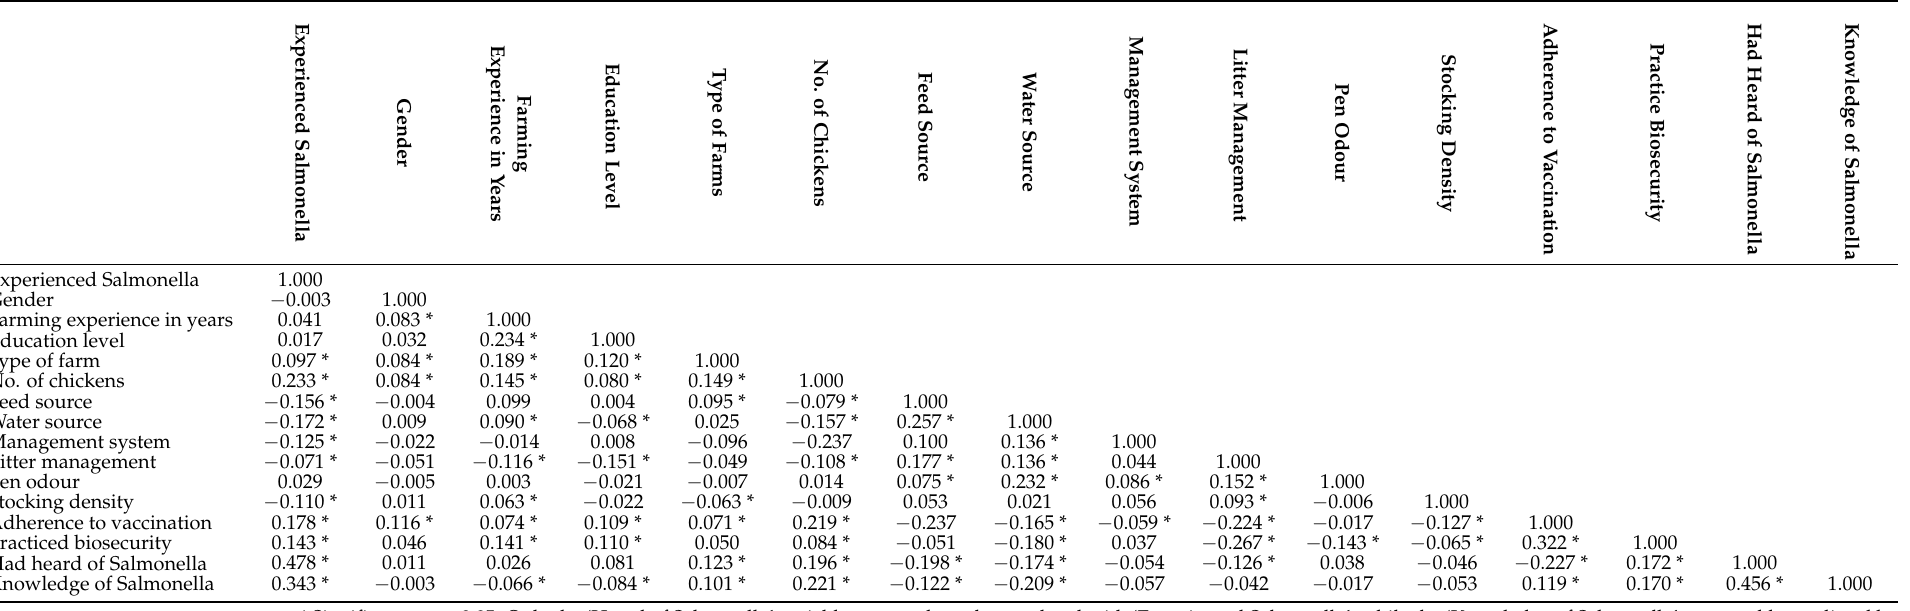
Table 3. Pairwise correlation of selected variables for incidence of non-typhoidal Salmonella on poultry farms, North Central